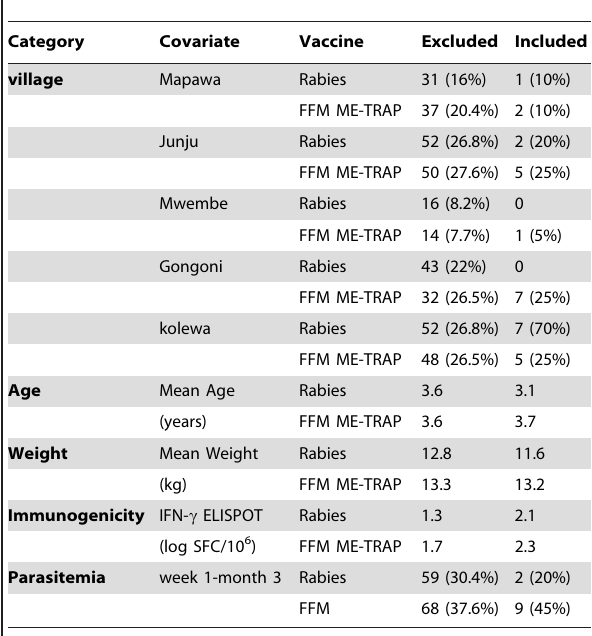
Table 1. Description of subjects selected for qPCR